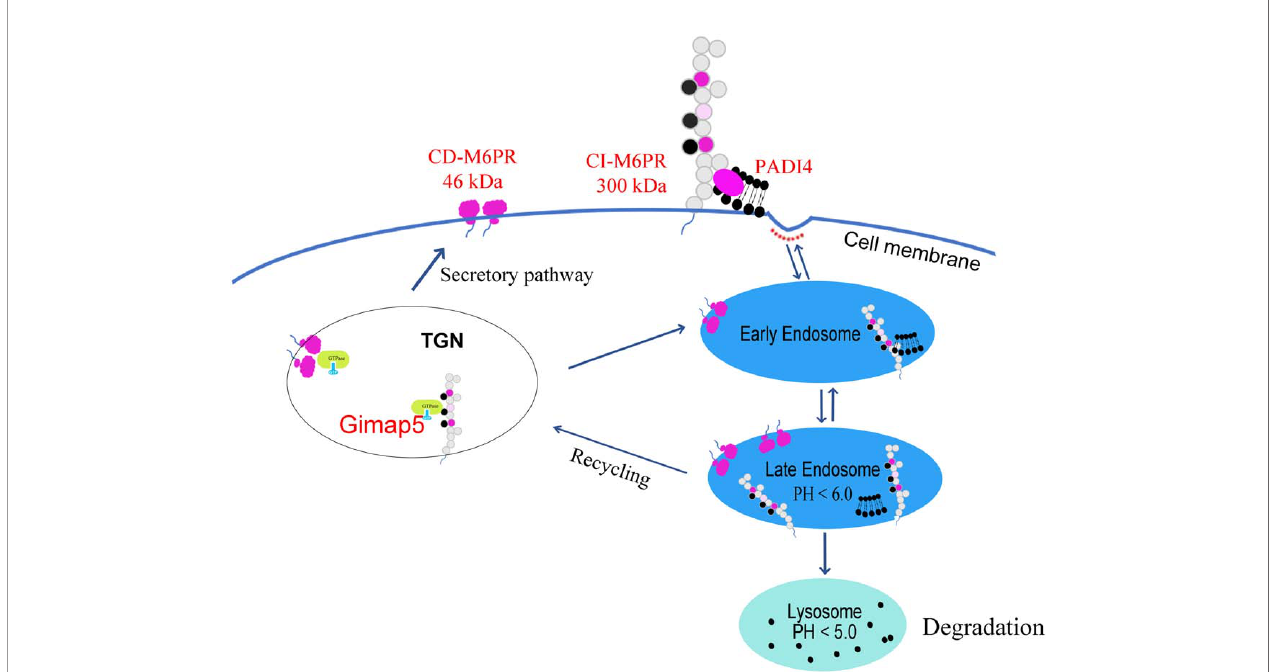
FIGURE 8 | Gimap5 promoted the transport of M6PR from cytoplasm to cell membrane through the interaction with M6PR, and M6PR inhibited the function of M6P modi fi ed ligands such as PADI4, thus inhibiting PADI4-related EMT and lung cancer